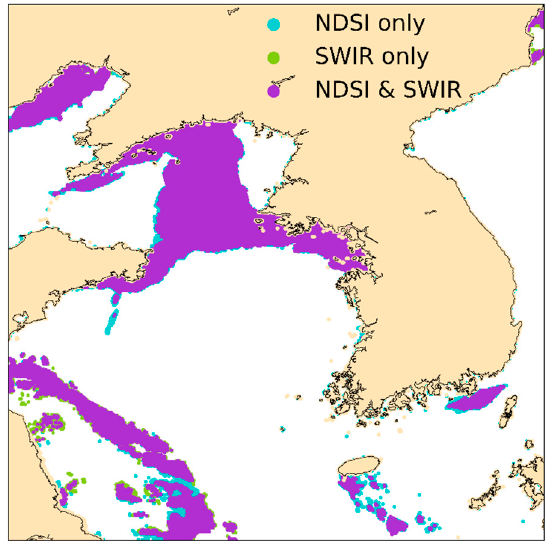
Figure 8. Quantitative comparison of the proposed sea fog detection algorithm and AHI BTD sea fog algorithm. POD, PAG, CSI, and HSS values were 0.954, 0.887, 0.851, and 0.911,